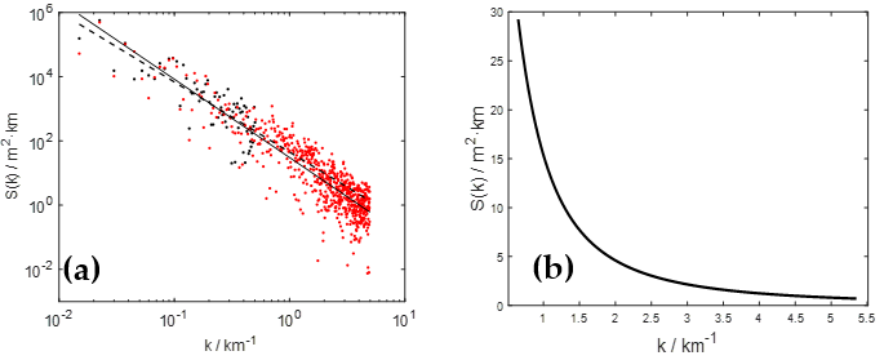
Figure 6. ( a ) The meridional terrain height variance spectra in the log–log coordinate and ( b ) the deviation of the spectral energy between 30 ″ resolution and 90 m resolution above the wavenumber of 1.86 km − 1 . The dashed line is the fitting spectral slope of 30 ″ resolution based on the black dots and the solid line represents the slope of 90 m resolution based on the red dots.